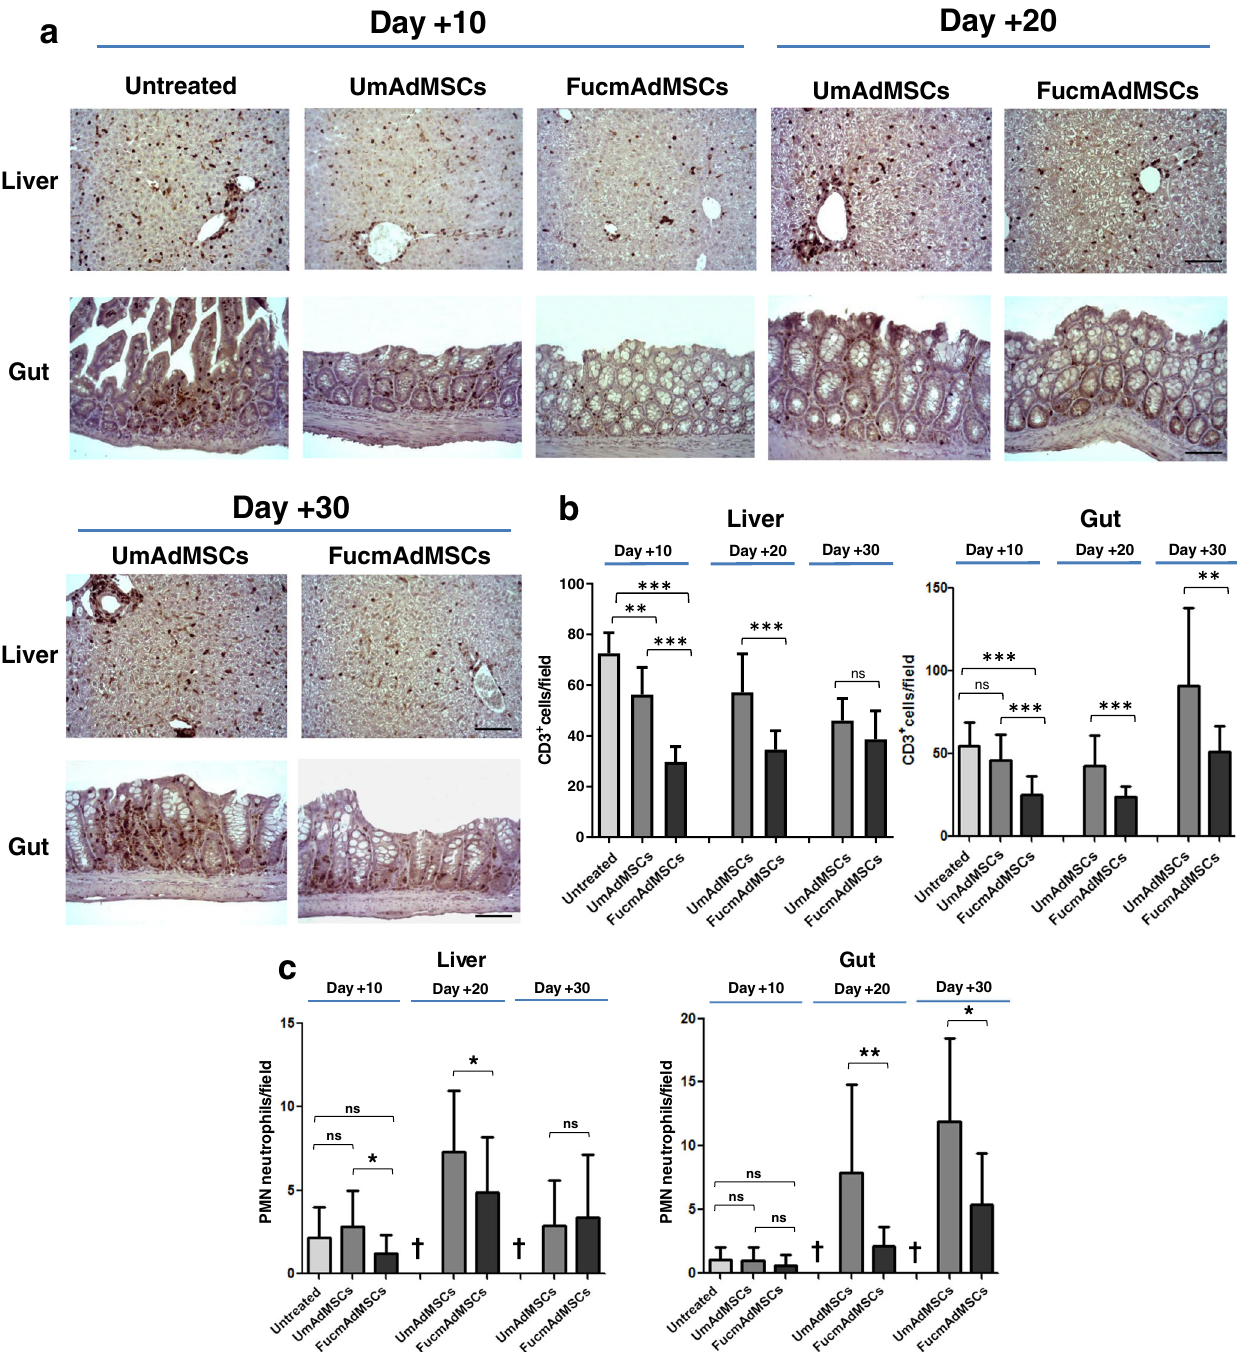
Fig. 3 Allo-HSCT/S recipients administered HCELL + mAdMSCs have lower CD3 + lymphocyte and polymorphonuclear neutrophil (PMN) in fi ltrates in liver and gut. Tissues from animals with ongoing aGvHD, either Untreated or treated with either type of mAdMSCs, were isolated after 10, 20, or 30 days after allo-HSCT/S. a CD3 + T cell in fl ammatory in fi ltrate was then detected by standard anti-CD3 ABC colorimetric immunohistochemistry. Representative images of CD3 + T cell in fi ltrates within liver and gut from the different mouse groups are shown (magni fi cation ×200, Scale bar: 100 μ m). b Bar graphs depict absolute T cells counts (CD3 + cells), presented as mean ± SD per high-power fi eld from counts relative to 10 high-power fi elds (magni fi cation ×200) ( n = 5 mice per group). Compared to Untreated mice, mice receiving UmAdMSCs and FucmAdMSCs had signi fi cantly less T cell in fi ltrates, with lowest in fi ltrates in those mice receiving FucmAdMSCs (** p < 0.01 or *** p < 0.001), analyzed by one-way ANOVA with Tukey ’ s multiple-comparisons test. c PMNs were identi fi ed in tissue sections on basis of characteristic morphologic appearance of lobulated nuclei. Absolute PMN counts are presented as mean ± SD per high-power fi eld from counts relative to 10 high-power fi elds (magni fi cation ×400) ( n = 5 mice per group). As shown by asterisks, statistically signi fi cant differences in the extent of PMN in fi ltrates were observed among mice that received UmAdMSCs versus those that received FucmAdMSCs, * p < 0.05 or ** p < 0.01, res p ectively, analyzed by one-way ANOVA with Tukey ’ s multiple-comparisons